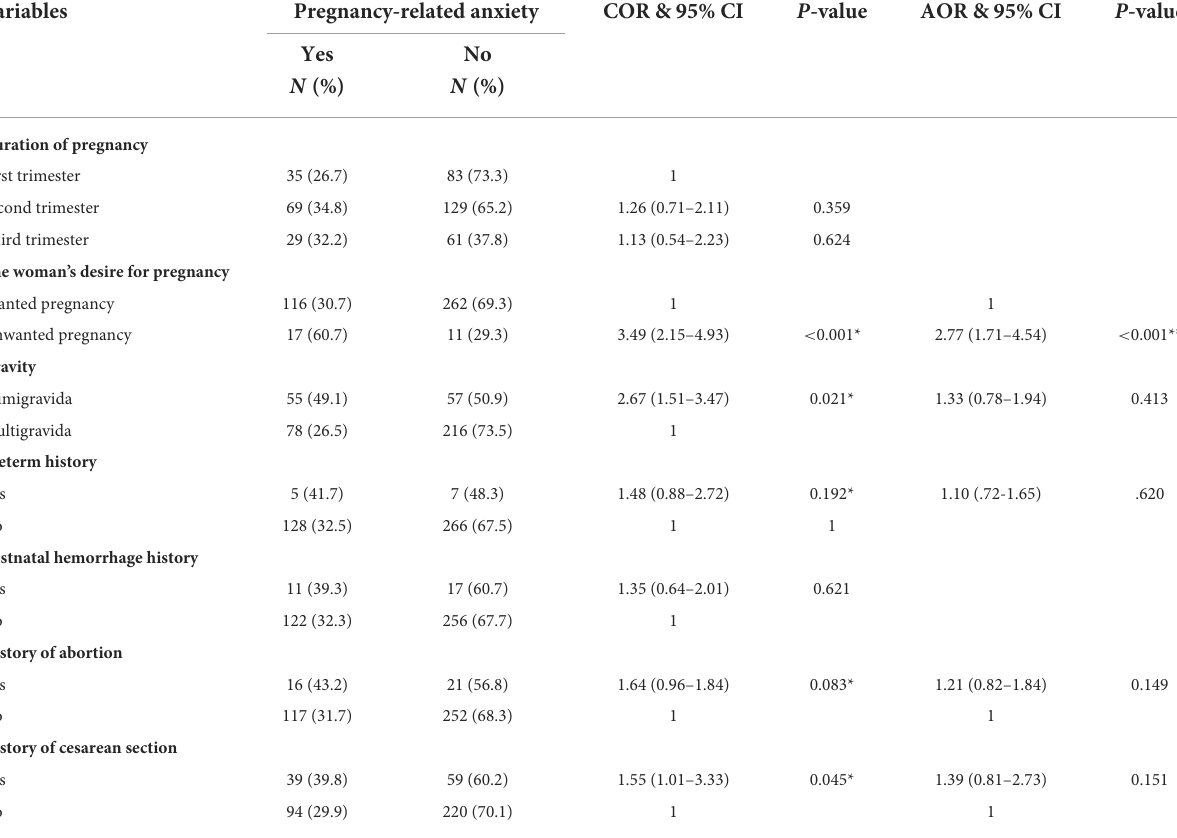
TABLE 6 Bivariate and Multivariate binary logistic regression analysis showing the association between PRA and previous obstetrics and pregnancy related variables among pregnant women attending ANC follow up Bedelle general hospital and Metu Karl comprehensive specialized hospital, 2021 ( N =